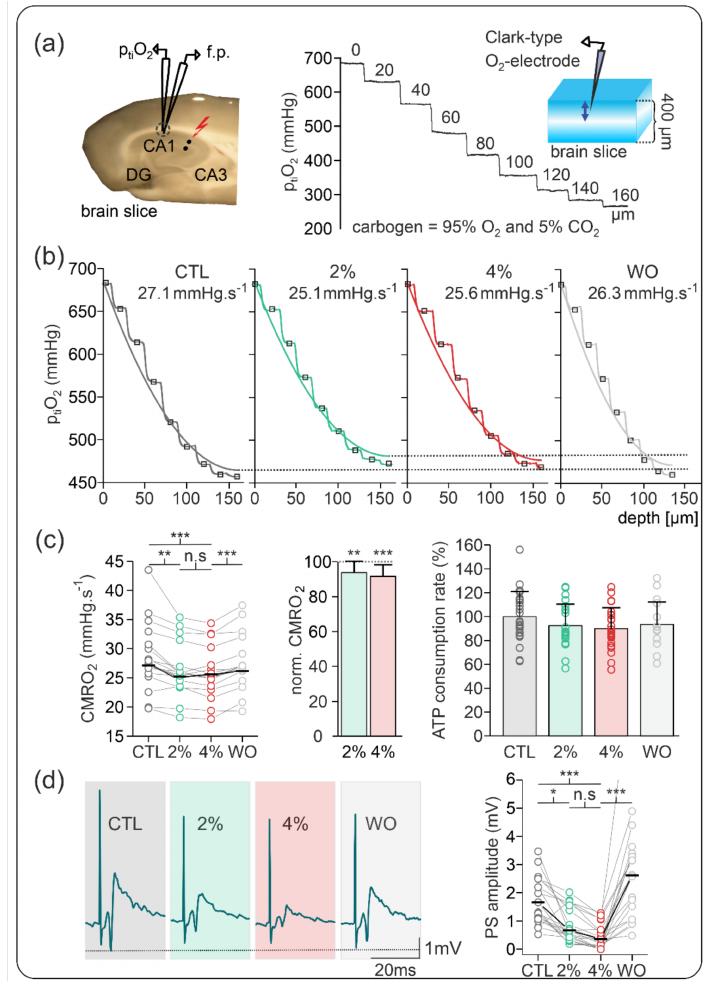
Figure 1. Sevoflurane-induced changes on cerebral metabolic rate of oxygen (CMRO 2 ) and synaptic activity in naive slices. ( a ) Representation of recording settings for simultaneous measurements of partial tissue oxygen pressure (p ti O 2 ) and stimulus-induced population spikes (PSs). Left: Field potential (f.p.) electrode and Clark-style oxygen electrode (p ti O 2 ) were positioned in the stratum pyramidale of area CA1 while a stimulation electrode (black dots) was placed in the stratum radiatum in area CA2. Right: Exemplary recording of p ti O 2 depth profile in slices gassed with carbogen in an interface condition. Under these conditions, the p ti O 2 of approximately 682 mmHg at the surface of the slices decayed until the lowest oxygen values at the core of the slice. ( b ) Exemplary p ti O 2 depth profiles and CMRO 2 values as calculated using a reaction–diffusion model in the different conditions: control (CTL, black), under 2% sevoflurane (green), under 4% sevoflurane (red), and after washout (WO, grey). ( c ) Plots of recorded absolute CMRO 2 values (left) and normalized CMRO 2 changes (middle) showing a small but significant decrease under 2% sevoflurane, no further significant changes under 4% sevoflurane, and reversibility. Based on the experimental data, the computed relative adenosine triphosphate (ATP) consumption rate slightly decreased in the presence of sevoflurane (right). ( d ) Effects of sevoflurane on stimulus-induced PSs in area CA1. Left: Example traces of PSs in the control condition (dark grey background), under 2% and 4% sevoflurane (green and red backgrounds, respectively) and after washout (grey background). Right: Plot of absolute PS amplitude showing a concentration-dependent decrease under 2% and 4% sevoflurane. After washout, PSs increased, suggesting good reversibility and synaptic facilitation. All point line charts display the median in addition to the absolute values. The bar charts display mean + standard deviation (SD). Statistical comparison: repeated measures ANOVA and Bonferroni post hoc test. * = p < 0.05, ** = p < 0.01, *** = p < 0.001, n.s = p >